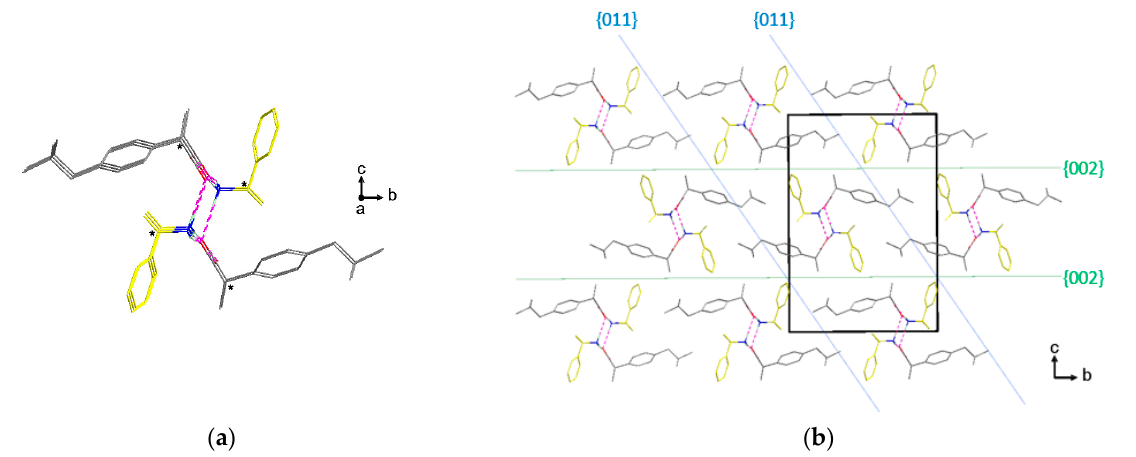
Figure 10. ( a ) Molecular chain of S-IBU/S- α -MBA spreading along the ‘a’ axis. The carbon atoms are displayed in yellow for S- α MBA and in grey for S-IBU. Chiral carbon for both molecules is highlighted with an asterisk. ( b ) Projection along the ‘a’ axis of the S-IBU/S- α -MBA crystal structure. The slices {002} and {011} are shown; their surfaces are clearly hydrophobic. Table 1. Comparison between the lattice parameters of the ss-S-IBU/S- α MBA with a composition of X R-IBU/S- α MBA = 0.14 (powder), the single crystal (X R-IBU/S- α MBA ≈ 0.18), and the pure salt S-IBU/S- α MBA (powder). Data obtained from the software Material